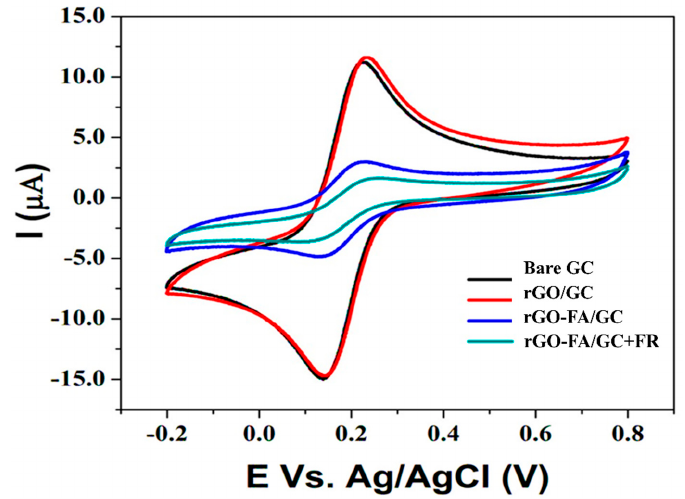
Figure 6. CV analysis of bare GC, rGO/GC, rGO-FA/GC, and rGO-FA/GC + 10 nM FR in 0.1 M [Fe(CN) 6 ] 3 − /4 − at a scan rate of 50 mV s − 1 .